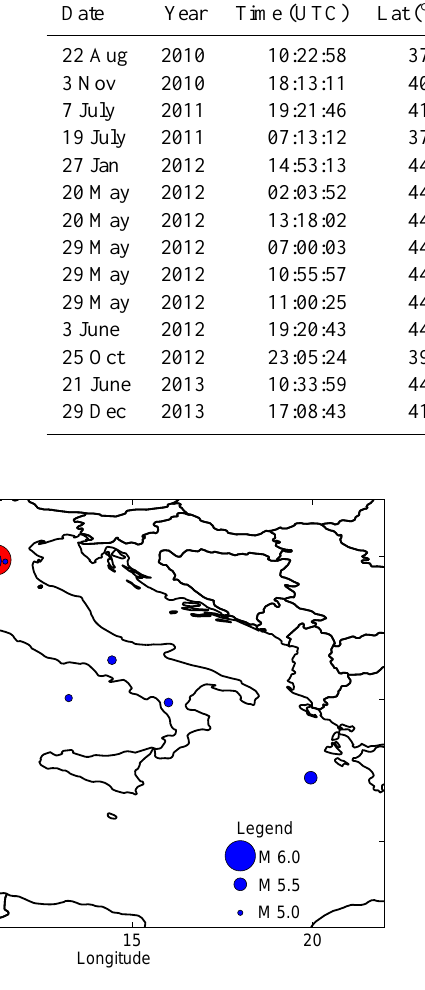
Figure 2. Map showing locations of magnitude M ≥ 5 earthquakes listed in Table 2 that occurred in and near Italy (lat. 35–48 ◦ N, long. 6–20 ◦ E) during 2010–2013. The red circle indicates the location of the 20 May 2012 earthquake that Guangmeng and Jie (2013) claim to have predicted. The areas of the circles are scaled with the approximate earthquake